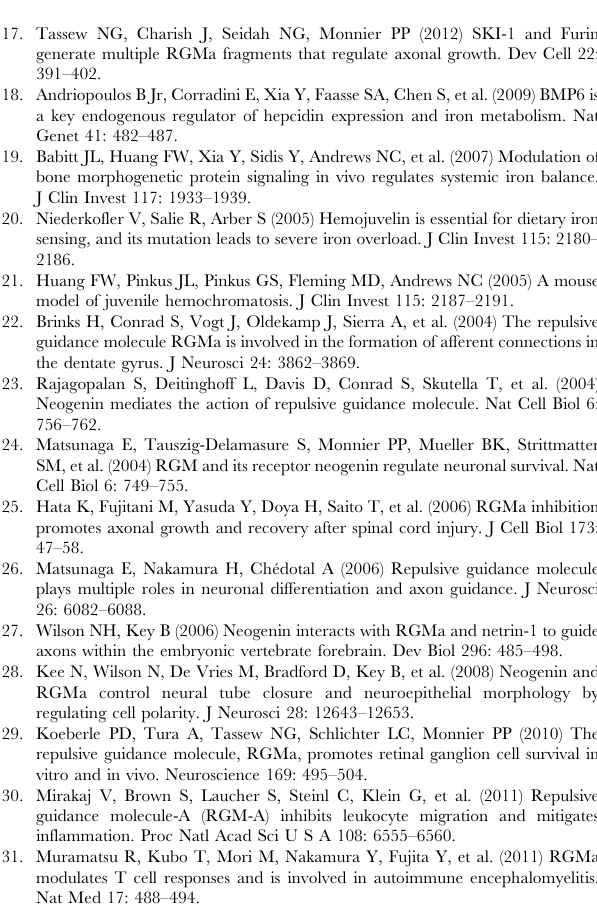
of 198.5 RU. (C) RGMA protein was diluted in running buffer HBS-EP + into a series of concentration (10, 20, 40, 80 and 160 nM) and injected through CM5 chip immobilized with BMP2 at a density of 198.5 RU. (A–C) Color lines represent the fitted curves plotted from the 1:1 Langmuir binding model and the black line represents the experimental curves. The kinetics data (K D , K on , and K off ) and quality control parameters ( x 2 , U, T(K on ) and T(K off )) are shown in the tables below each sensogram. Figure S5 Representative sensograms of kinetics ex- periments between BMP4 and RGM proteins by SPR. (A) HJV protein was diluted in running buffer HBS-EP + into a series of concentration (5, 10, 20, 40 and 80 nM) and injected through CM5 chip immobilized with BMP4 at a density of 40.2 RU. (B) RGMB protein was diluted in running buffer HBS-EP + into a series of concentration (2, 4, 8, 16 and 32 nM) and injected through CM5 chip immobilized with BMP4 at a density of 96.1 RU. (C) RGMA protein was diluted in running buffer HBS- EP + into a series of concentration (10, 20, 40, 80 and 160 nM) and injected through CM5 chip immobilized with BMP4 at a density of 95.2 RU. (A–C) Color lines represent the fitted curves plotted from the 1:1 Langmuir binding model and the black line represents the experimental curves. The kinetics data (K D , K on , and K off ) and quality control parameters ( x 2 , U, T(K on ) and T(K off )) are shown in the tables below each sensogram. (TIF)